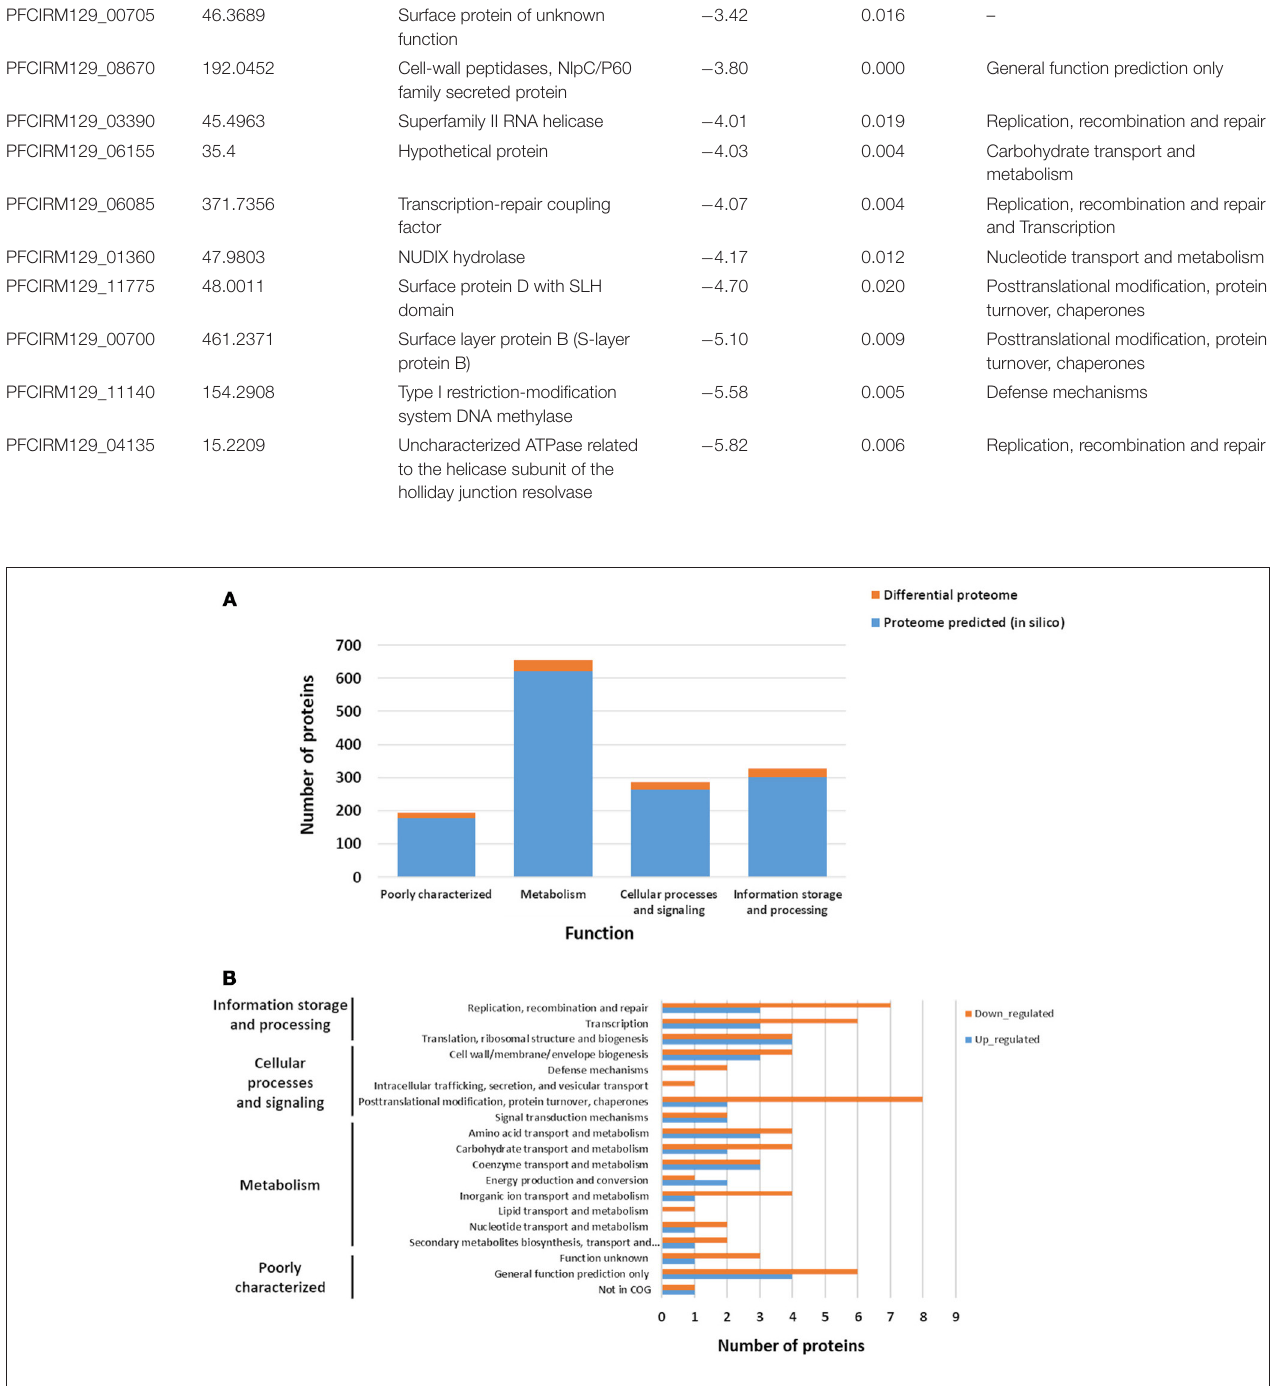
FIGURE 5 | Repartition of differential proteins in biological processes. (A) Functional distribution of the predicted theoretical proteome and of the experimental differential proteins when comparing Wild-type (WT) and mutant CB129 1 slpB strains. (B) Repartition of differential proteins in Biological processes. Functional distribution and Biological process were predicted based on the functional classifications of COG